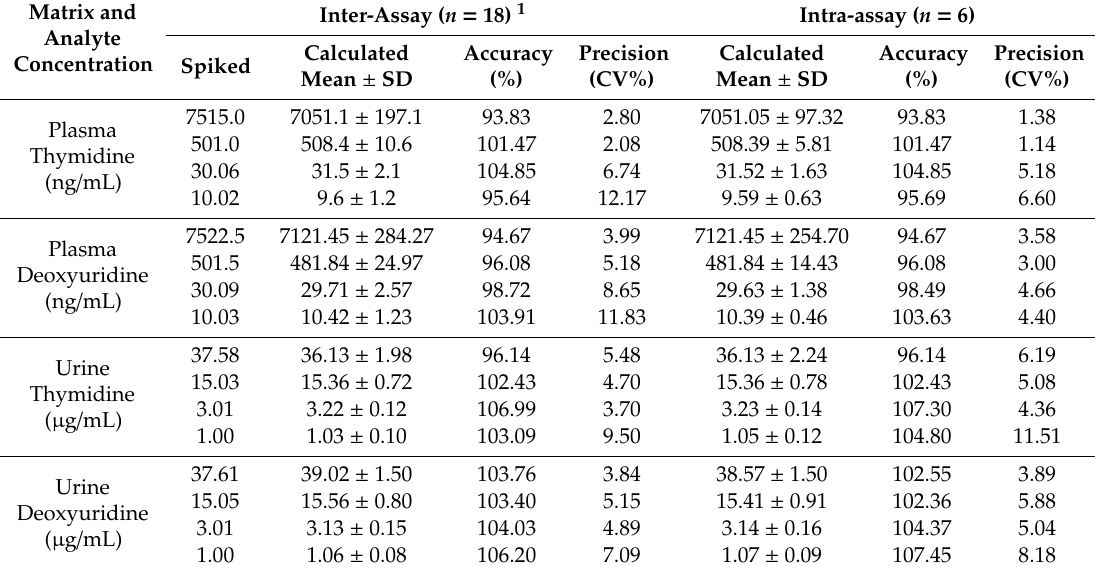
Table 1. Intra-day and inter-day accuracy and precision for urine and plasma assays. Each QC level was measured in six replicates on three di ff erent